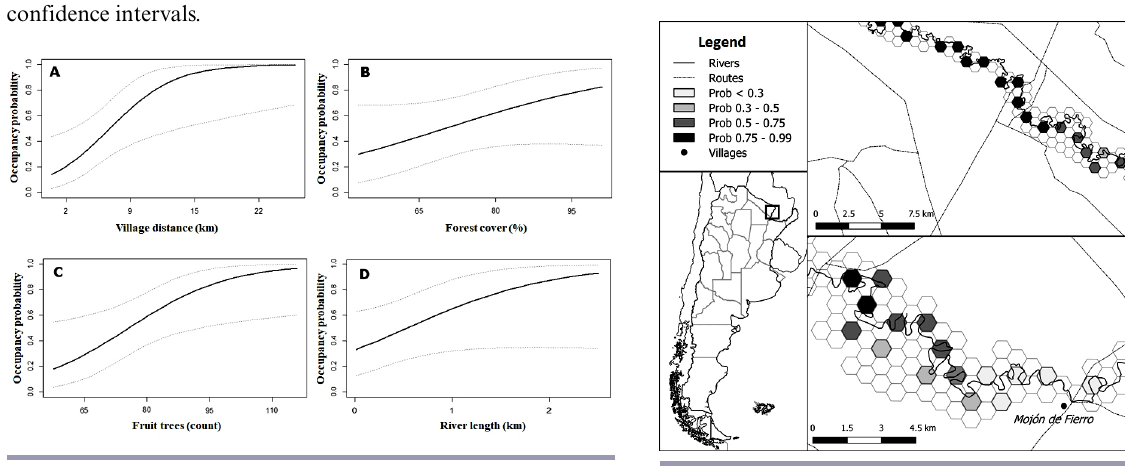
Fig. 4 . Maps of conditional occupancy probability for Bared- face Curassow in the Humid Chaco, northern Argentina. The conditional occupancy probability was estimated by the average model for this